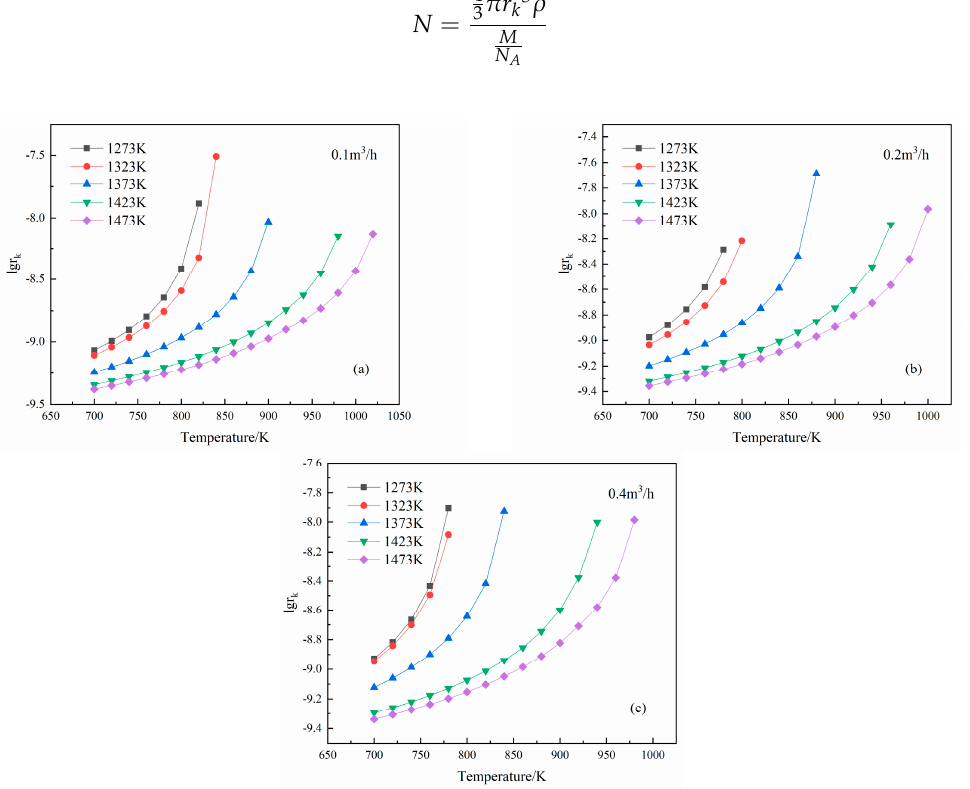
Figure 7. Relationship between the critical nucleation radius and temperature: ( a ) 1273–1473 K heating, 0.1 m 3 / h Ar, ( b ) 1273–1473 K heating, 0.2 m 3 / h Ar, ( c ) 1273–1473 K heating, 0.4 m 3 / h